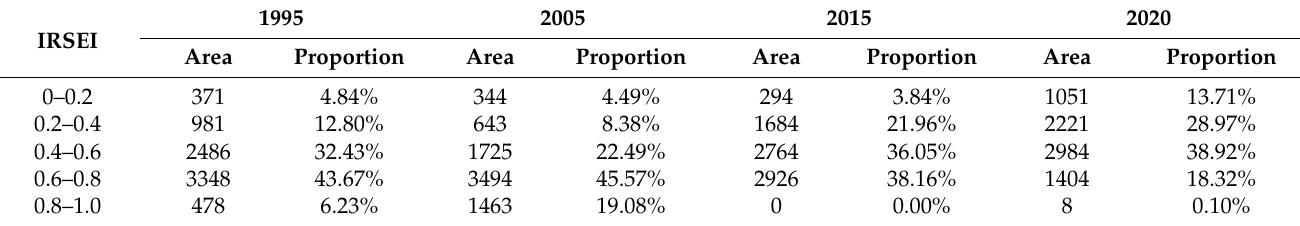
Figure 5. Changing area proportion of the IRSEI in Wuhan from 1995 to 2020. Table 5. Area and proportion of the IRSEI over 1995 to 2020 in Wuhan city (unit: km 2 ,